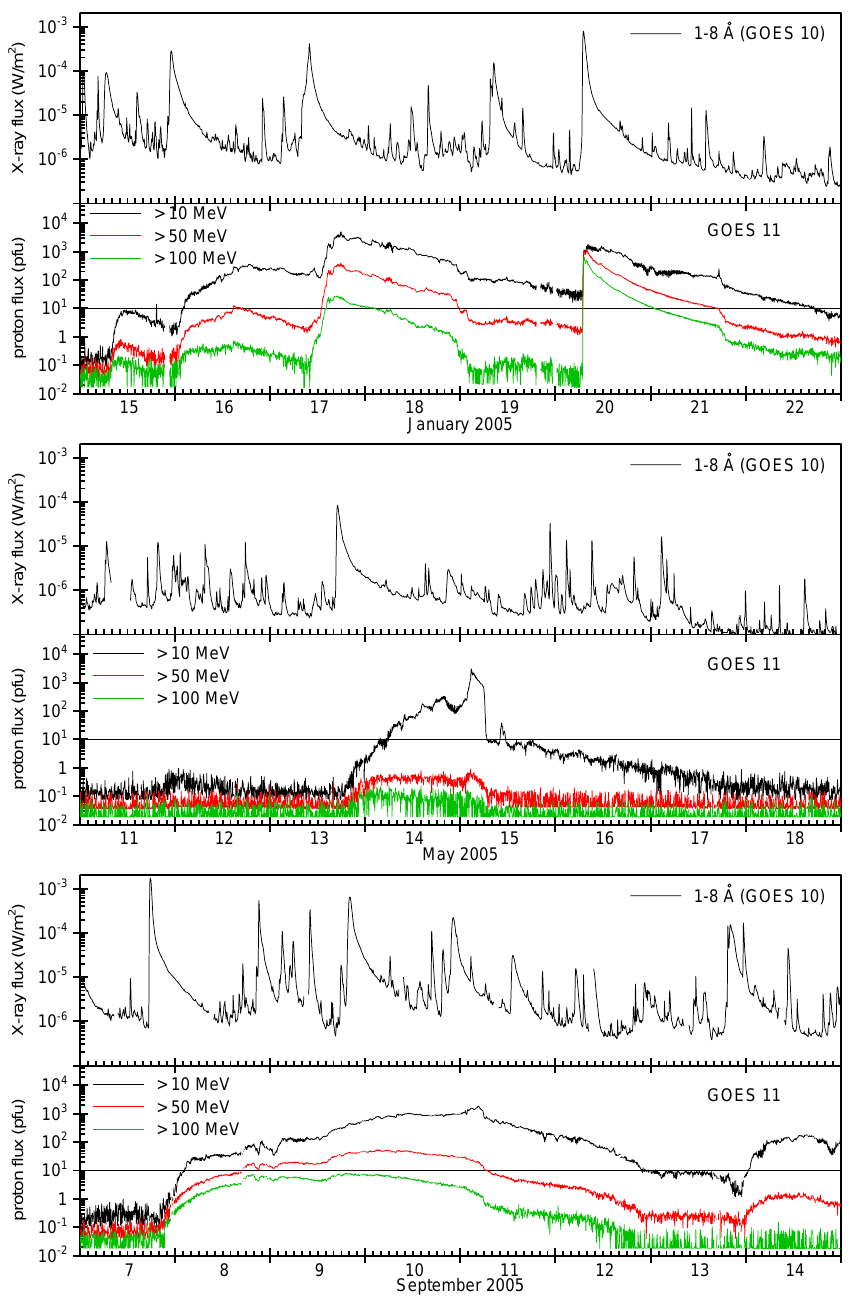
Fig. 1. Time-intensity profiles of the soft X-ray and the proton fluxes in several energy intervals ( > 10, > 50, > 100MeV), for all the selected